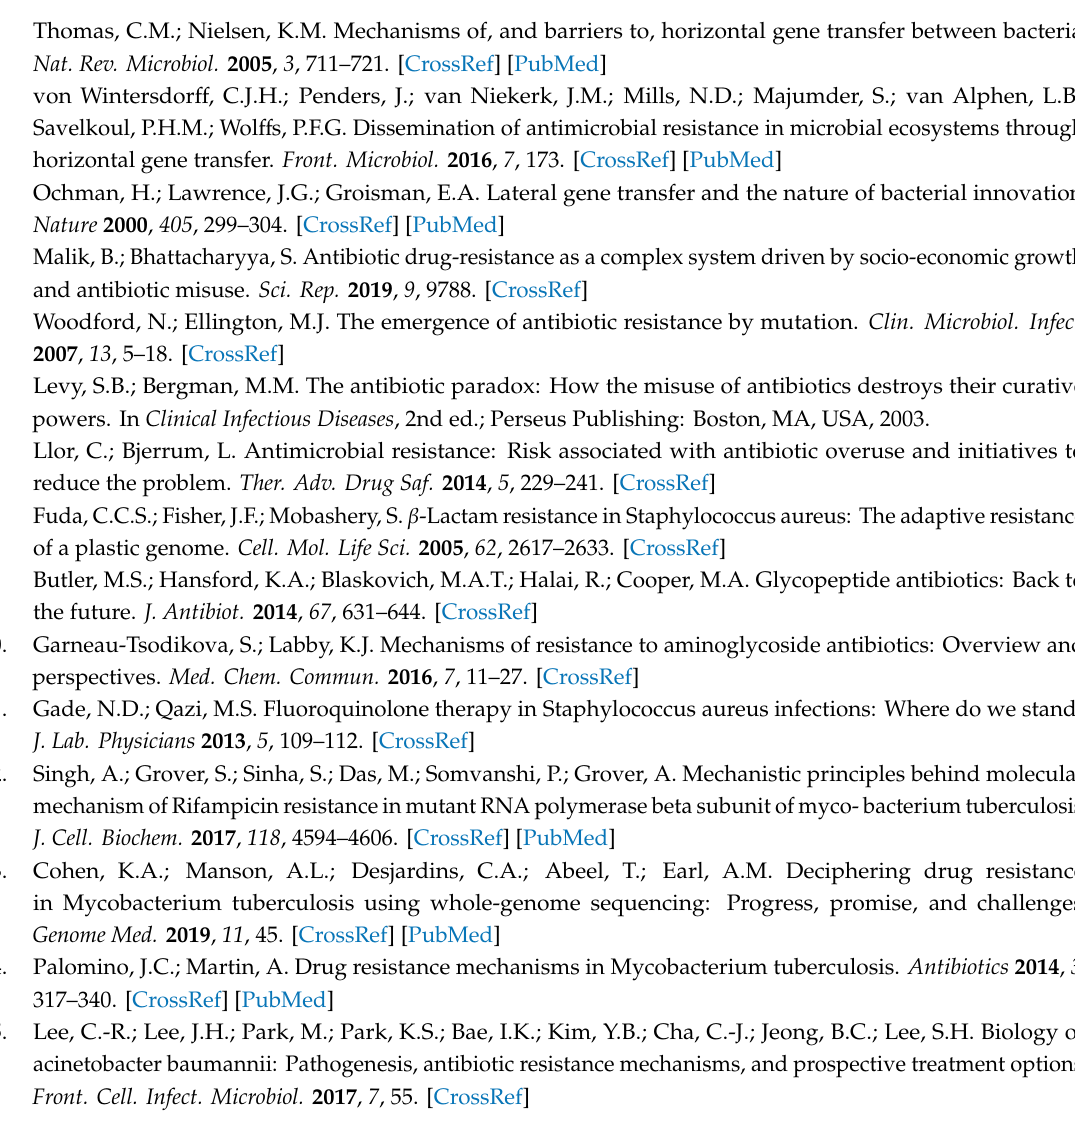
Figure S3: 1 H NMR spectrum of 1,2,3-triazole glucoside 6 (CDCl3, 400 MHz); Figure S4: 13 C NMR spectrum of 1,2,3-triazole glucoside 6 (CDCl3, 100 MHz), Figure S5: 1 H NMR spectrum of 1,2,3-triazole glucoside 7 (CDCl3, 400 MHz), Figure S6: 13 C NMR spectrum of 1,2,3-triazole glucoside 7 (CDCl3, 100 MHz), Figure S7: 1 H NMR spectrum of 1,2,3-triazole glucoside 9 (CDCl3, 400 MHz), Figure S8: 13 C NMR spectrum of 1,2,3-triazole glucoside 9 (CDCl3, 100 MHz), Figure S9: 1 H NMR spectrum of 1,2,3-triazole glucoside 10 (CDCl3, 400 MHz), Figure S10: 13 C NMR spectrum of 1,2,3-triazole glucoside 10 (CDCl3, 100 MHz), Figure S11: 1 H NMR spectrum of 1,2,3-triazole glucoside 11 (CDCl3, 400 MHz), Figure S12: 13 C NMR spectrum of 1,2,3-triazole glucoside 11 (CDCl3, 100